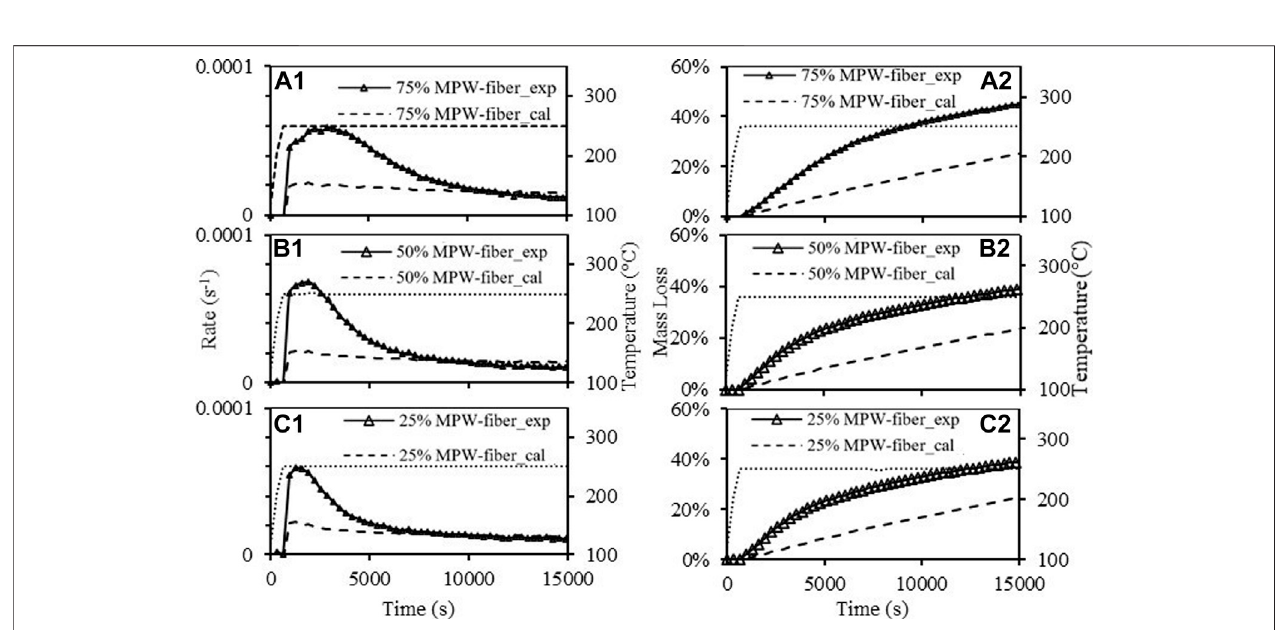
FIGURE 6 | Mass loss rate of paper-MPW torrefaction at 250 ° C with paper-MPW blend ratio of ( a1 , 3:1), ( b1 , 1:1), ( c1 , 1:3); Mass loss of paper-MPW torrefaction at 250 ° C with paper-MPW ratio of ( a2 , 3:1), ( b2 , 1:1), ( c2 , 1:3).